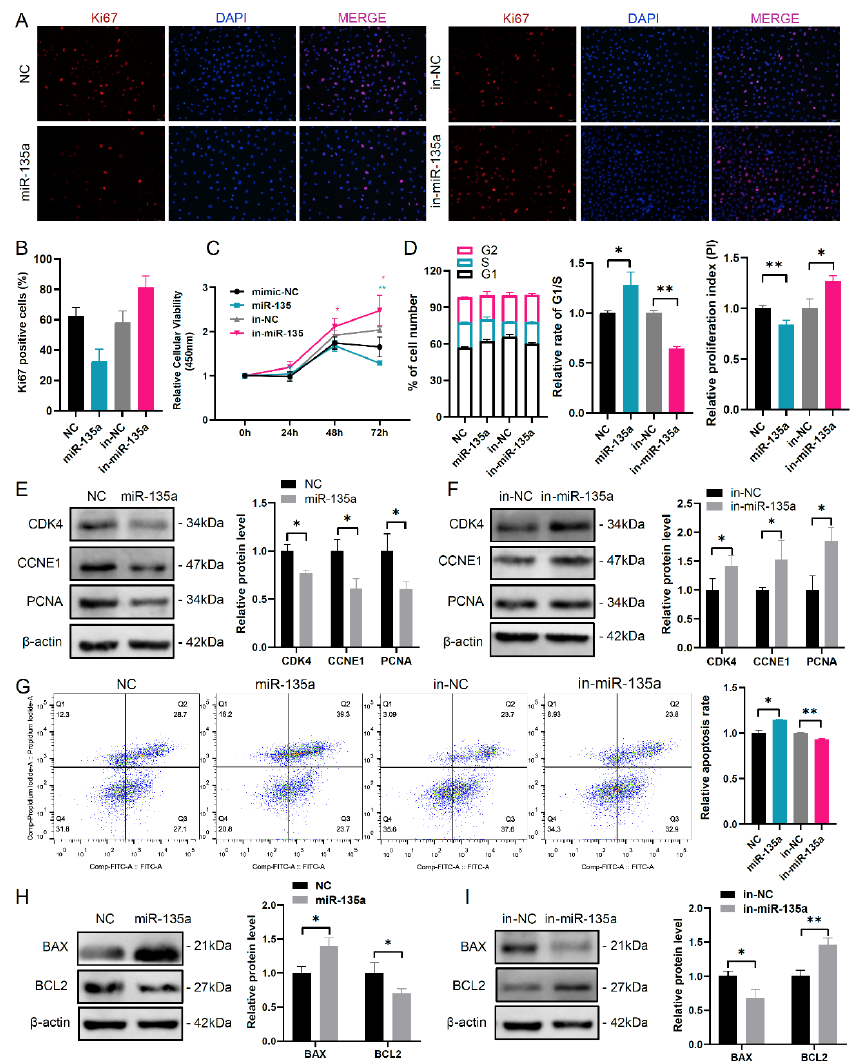
Figure 1. miR-135a represses cell proliferation in mGCs. ( A ) Immunofluorescence staining of cell proliferation marker Ki67 in mGCs. The nuclei were stained by DAPI (blue). Scale bar: 50 μ m. miR-135a mimics is abbreviated to miR-135a. Negative control is abbreviated to NC. miR-135a inhibitor is abbreviated to in-miR-135a. Negative control inhibitor is abbreviated to in-NC. ( B ) The quantification of the Ki67-positive cells in ( A ). ( C ) Cell viability was detected by CCK-8 in mGCs. ( D ) The cell cycle of miR-135a was detected by flow cytometry assay in mGCs. The distribution of mGCs in each phase of cell cycle was shown in left panel. The relative rate of G1/S in mGCs was shown in middle panel. PI (proliferation index, PI = (G2 + S)/G1) was shown in right panel. Western blot analysis of ( E ) cell cycle and ( F ) proliferation-related protein levels in mGCs. ( G ) Assessment of apoptosis using Annexin V-FITC/PI and flow cytometry in miR-135 overexpressed and inhibited mGCs. Western blot analysis of apoptosis-related protein level in miR-135 ( H ) overexpressed and ( I ) inhibited mGCs. * p < 0.05 and ** p < 0.01 compared with controls according to two-tailed Student’s t test.